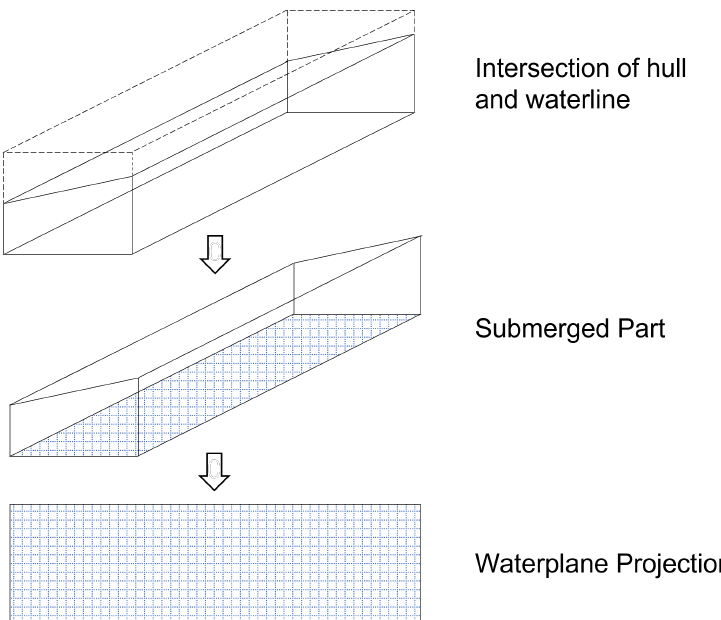
Figure 4. Projection of inclined waterline surface